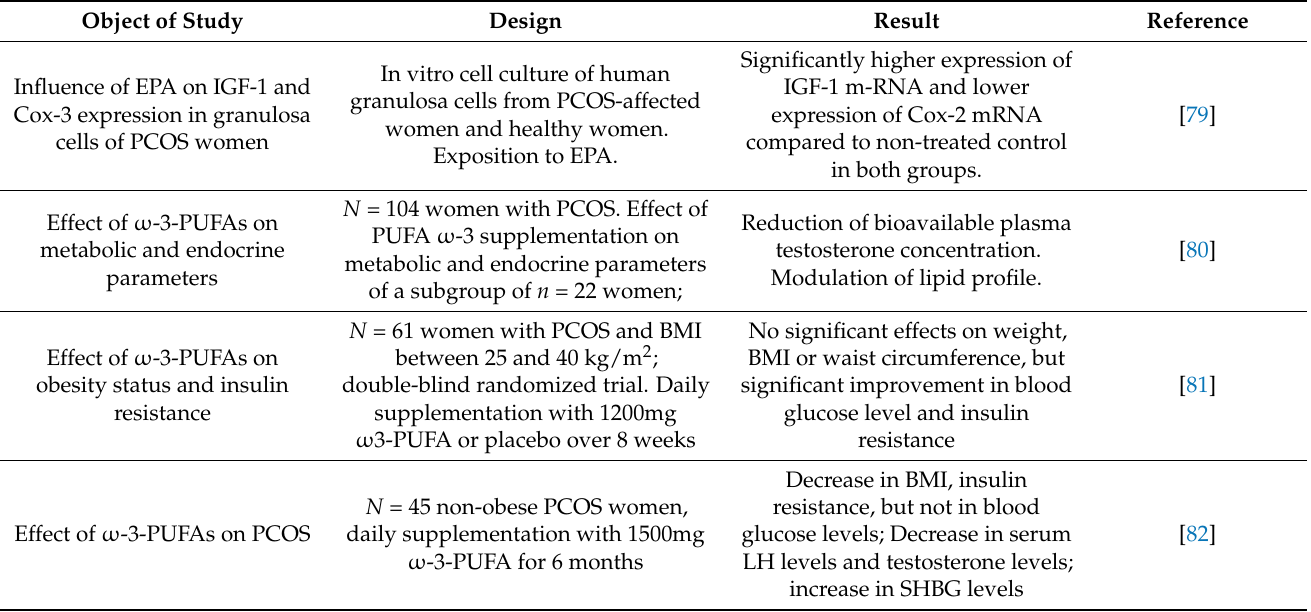
Table 1. Summary of studies on the effect of PUFAs on